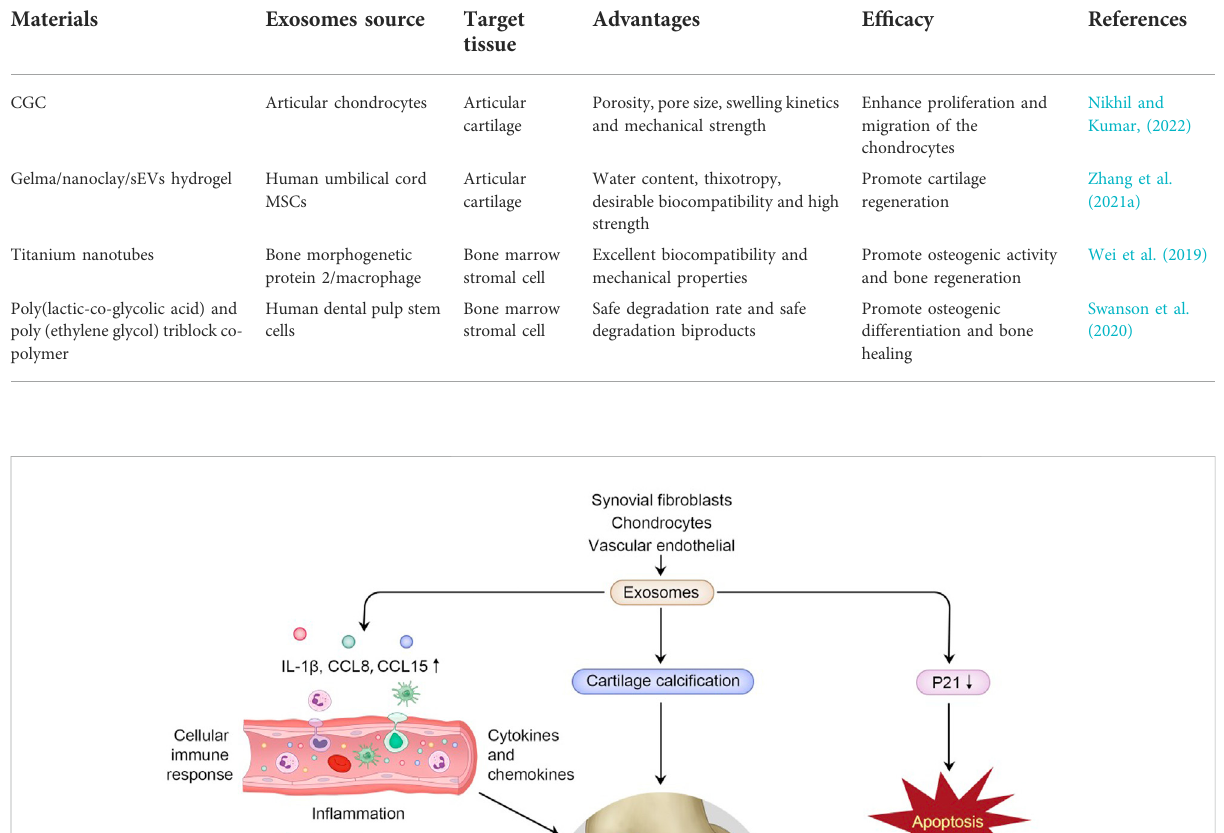
Frontiers in Cell and Developmental